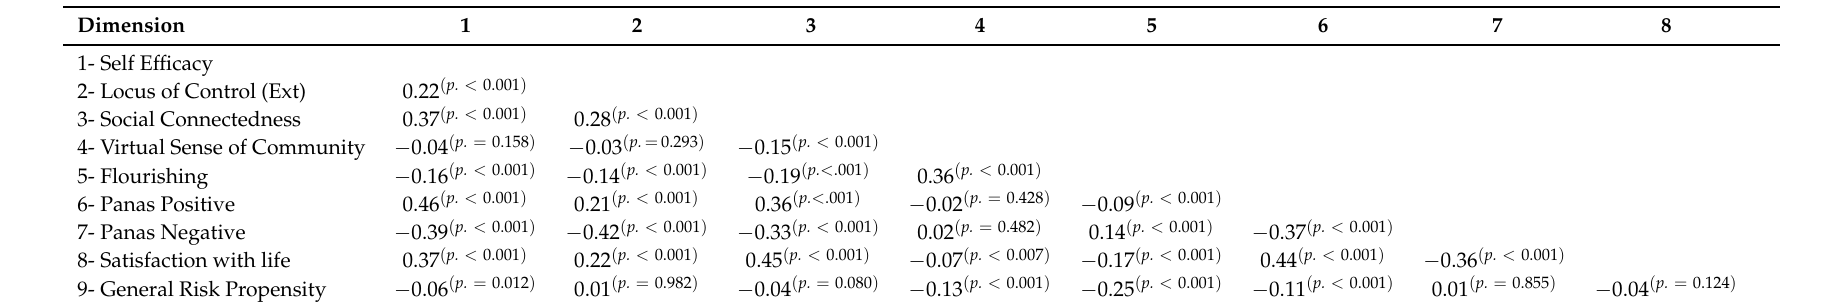
Table 6. Correlations between psychological